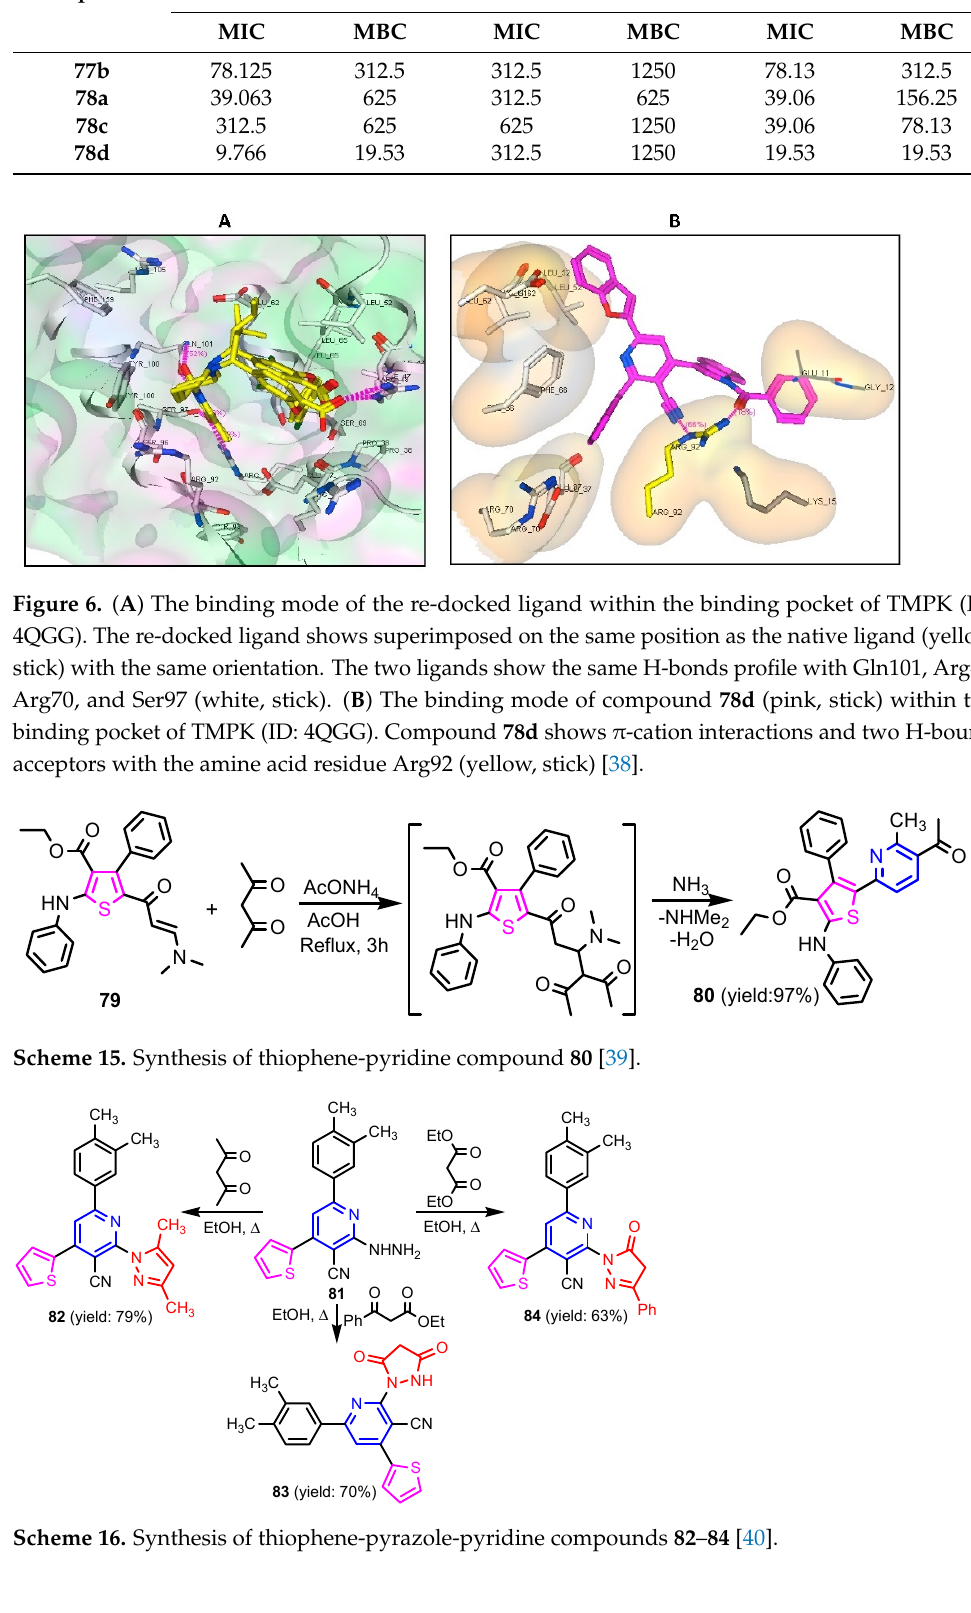
Figure 7. A. Docking into the active site of glucosamine-6-phosphate (GlcN-6-P) synthase (PDB ID: 2VF5). A. Docked poses of compounds 82 – 84 on the GlcN-6-P; B . the interaction the compound 84 and GlcN-6-P [40]. Ph PhO O N N PhH 3 C